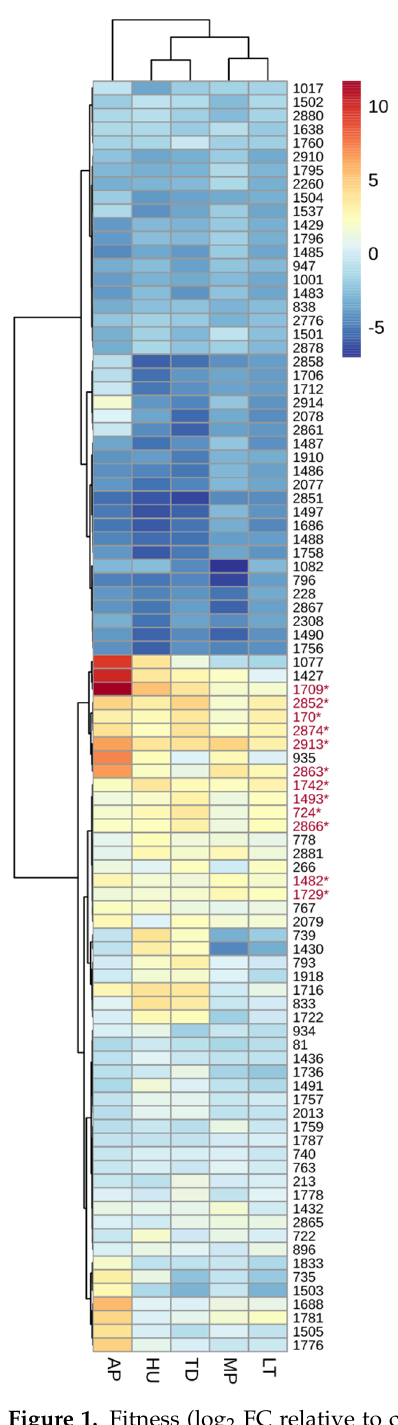
Figure 1. Fitness (log 2 FC relative to control conditions) of Saccharomyces cerevisiae strains in the presence of a non- Saccharomyces species. Data are clustered across fitness and treatments. Strains with an asterisk (*) showed a log 2 FC ≥ 1 across all treatments. AP: Aureobasidium pullulans , HU: Hanseniaspora uvarum , TD: Torulaspora delbrueckii , MP: Metschnikowia pulcherrima and LT: Lachancea thermotolerans.